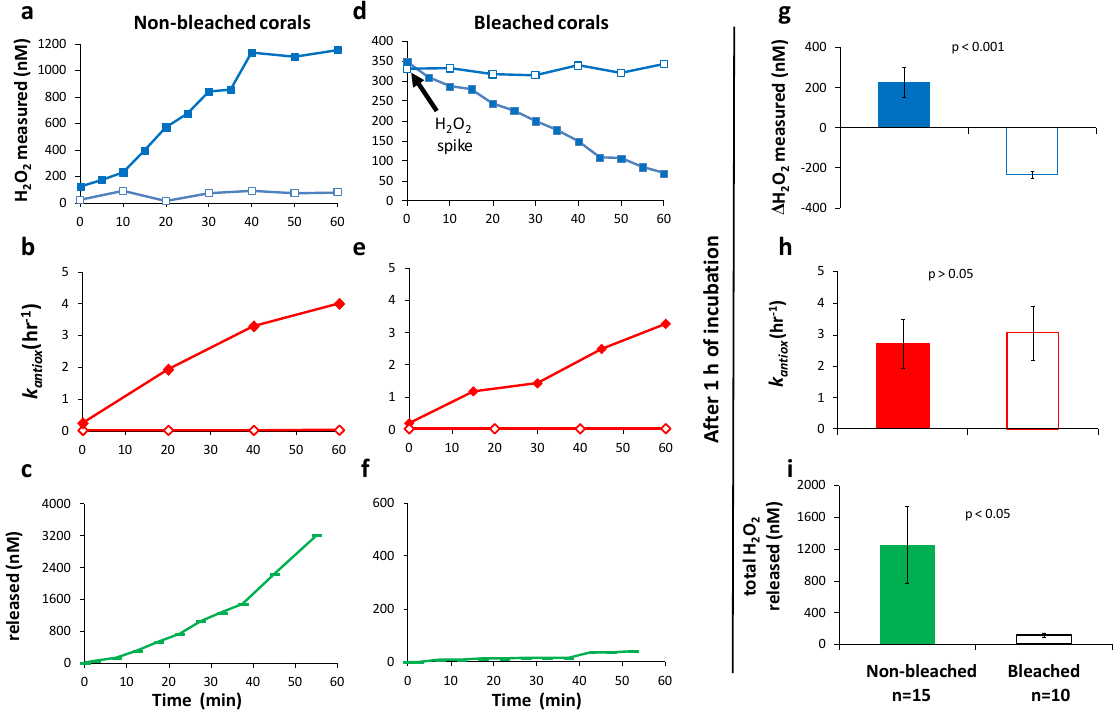
Figure 4. H 2 O 2 and antioxidant activity release from non-bleached and bleached S. pistillata . Line plots show changes with time in measured H 2 O 2 concentrations (a, d) , antioxidant activity (b, e) , and calculated H 2 O 2 release (c, e) from individual experiments with bleached (a–c) and non-bleached (d–f) corals. Parallel measurements in coral-free seawater of H 2 O 2 concentrations (a, d) and antioxidant activity (b, e) are shown using open symbols. Bar graphs show averaged values (mean ± SE) obtained from non-bleached ( n = 15) and bleached ( n = 10) coral fragments. These include the delta H 2 O 2 measured (i.e., H 2 O 2 at 1h minus the initial H 2 O 2 ) (g) , antioxidant activity at 1h (h) , and total H 2 O 2 released over 1h (i) . Differences between treatments were tested using the Mann–Whitney U test (g, i) and a student t test (h) . Note that the H 2 O 2 spike was added to the bleached coral (d) ; see text for